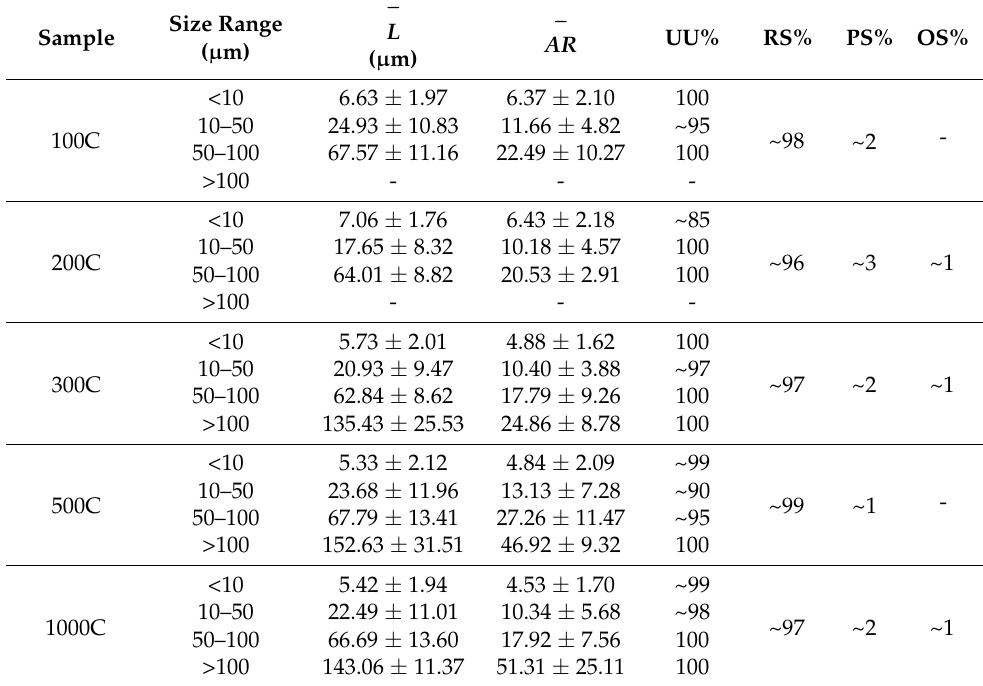
Table 14. The characteristics of elongated sulfides in the steel of 316L in different sized groups using Method